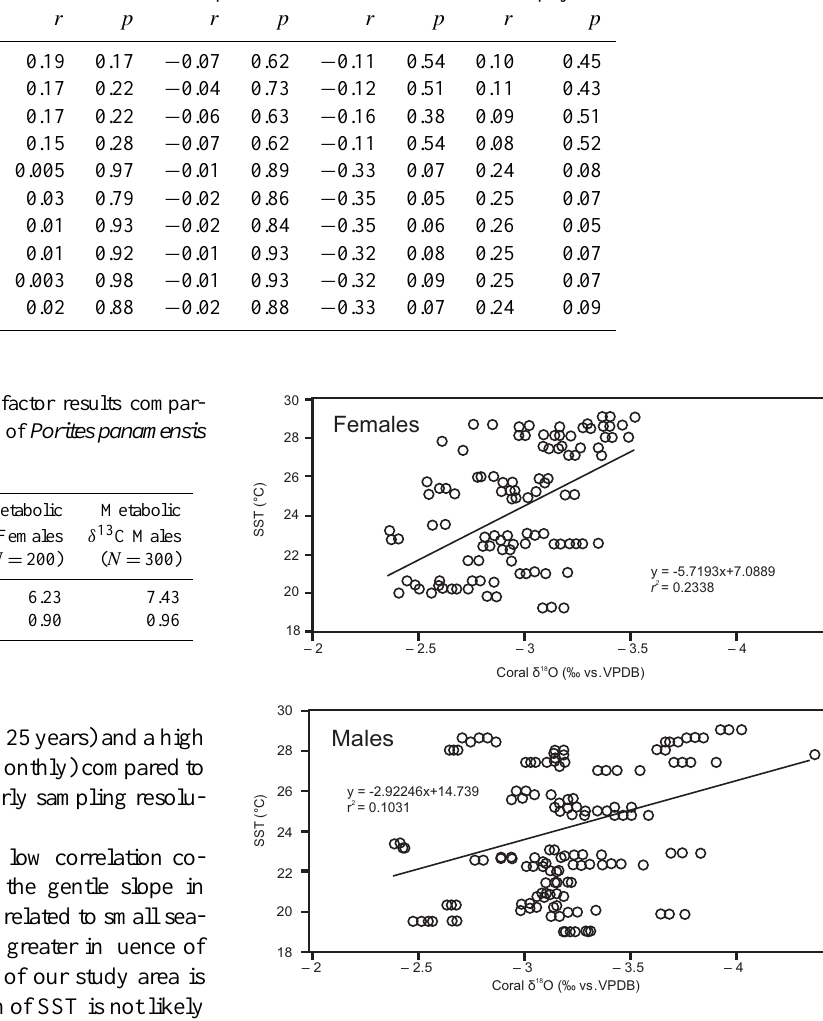
Figure 5. Linear regressions between satellite-derived sea surface temperature ( ◦ C) and skeletal δ 18 O (VPDB) of female, and male Porites panamensis coral from Bahía de La Paz. Time period cov- ered by analyses is from 1997 to 2009. Temporal resolution of data is quarterly. This includes all isotopic data of all colonies. Line equations and coefficients are